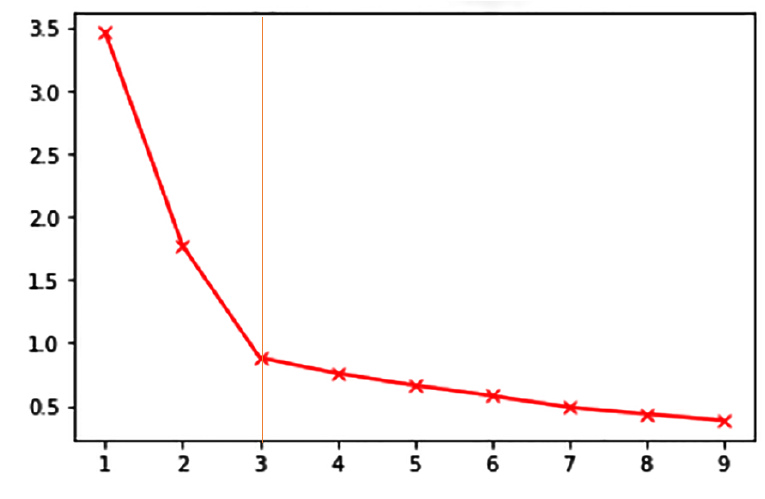
Figure 1. Determine The Knee Value of The Elbow